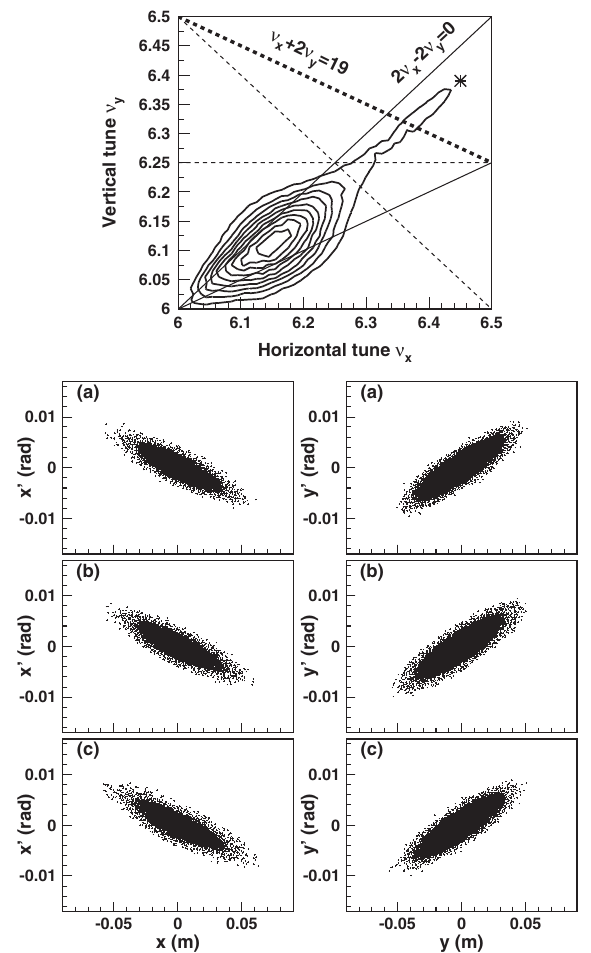
FIG. 8. Scintillation-type BLM signals over the first 1.4 ms measuredinthecollimatorsectionwithabeamintensityof850kW; (top) 100 π mm mrad transverse painting, (middle) 150 π mm mrad transverse painting, and (bottom) 150 π mm mrad transverse painting with QDTs.